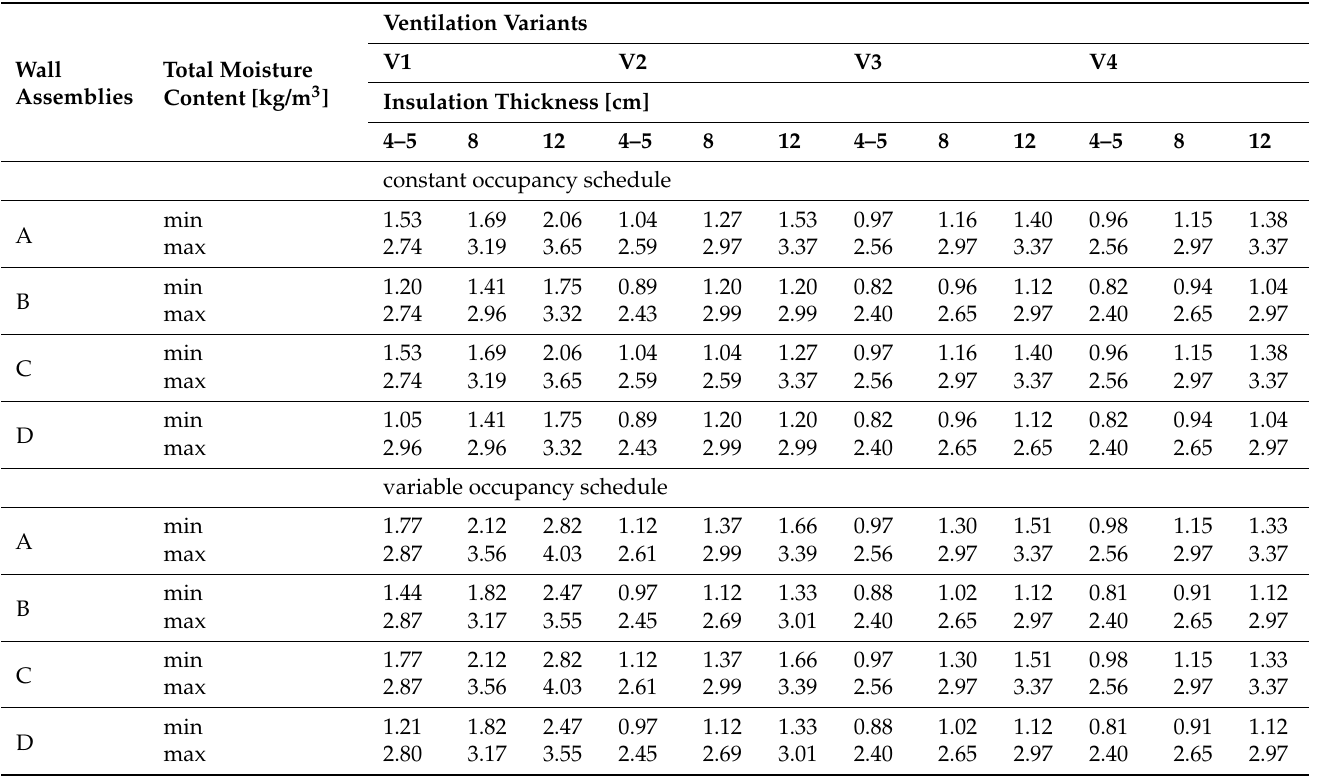
Table 4. Maximum and minimum values for total moisture